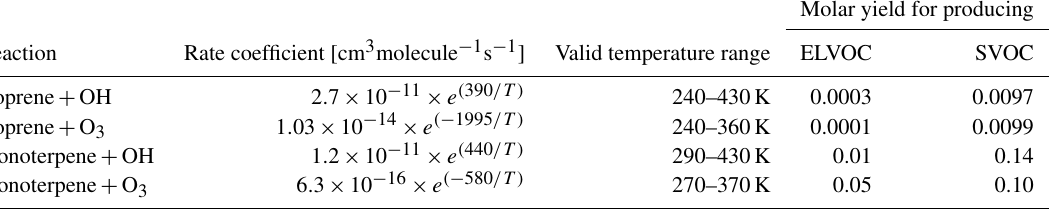
Table 1. Rate coefficients (Atkinson et al., 2006) and molar yields used to calculate production of ELVOCs and SVOCs in reactions between OH and O 3 as well as monoterpene and isoprene. The yields for monoterpene reactions are taken directly from Jokinen et al. (2015), whereas the isoprene yields are lowered to produce a total yield of 1% instead of 5%; see text for further information. Molar yield for